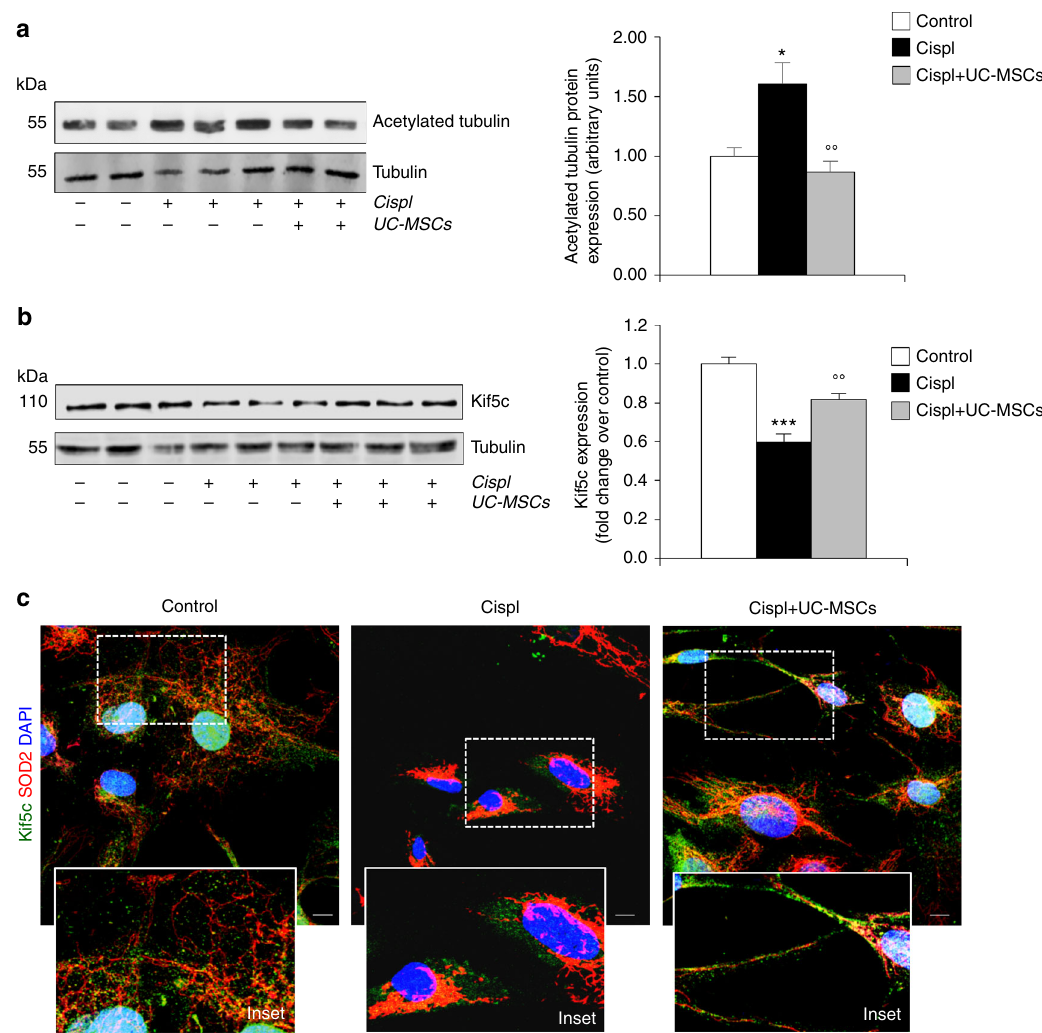
Fig. 5 Human UC-MSCs enhance mitochondrial traf fi cking through microtubule preservation and Kif5c expression in injured tubular cells. a Representative western blots and densitometric analysis of acetylated tubulin in control RPTECs ( n = 5), cisplatin-treated RPTECs alone ( n = 6), or co-cultured with UC-MSCs ( n = 6). * P < 0.05 vs Control and °° P < 0.01 vs Cispl using ANOVA corrected with Bonferroni coef fi cient. b Representative western blots and densitometric analysis of Kif5c in control RPTECs, cisplatin-treated RPTECs alone or co-cultured with UC-MSCs ( n = 6 independent experiments). *** P < 0.001 vs Control and °° P < 0.01 vs Cispl using ANOVA corrected with Bonferroni coef fi cient. c Representative images of immuno fl uorescence analysis of Kif5c (green) and SOD2-labeled mitochondria (red) in control RPTECs, cisplatin-treated RPTECs alone, or co-cultured with UC-MSCs ( n = 3 independent experiments). Nuclei are counterstained with DAPI (blue). Enlarged details of preserved Kif5c that co-localized with SOD2-labeled mitochondria in cisplatin-treated RPTECs exposed to UC-MSCs in respect to RPTECs treated with cisplatin alone, are shown in the insets. Scale bar 10 μ m. Data in a and b are expressed as mean ±